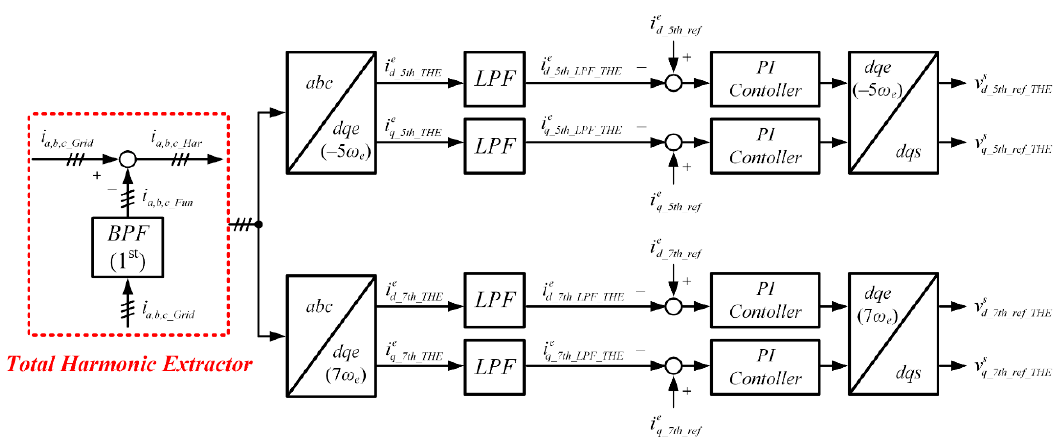
Figure 6. Block diagram of the THE (total harmonic extractor) method. BPF: bandpass filter.